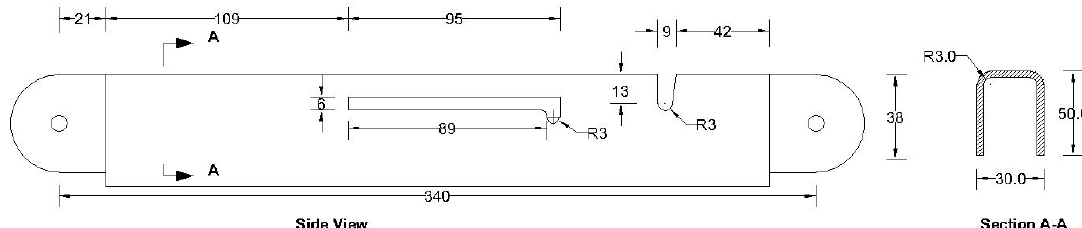
Figure 36. Revised primary folding link bar cross-section.